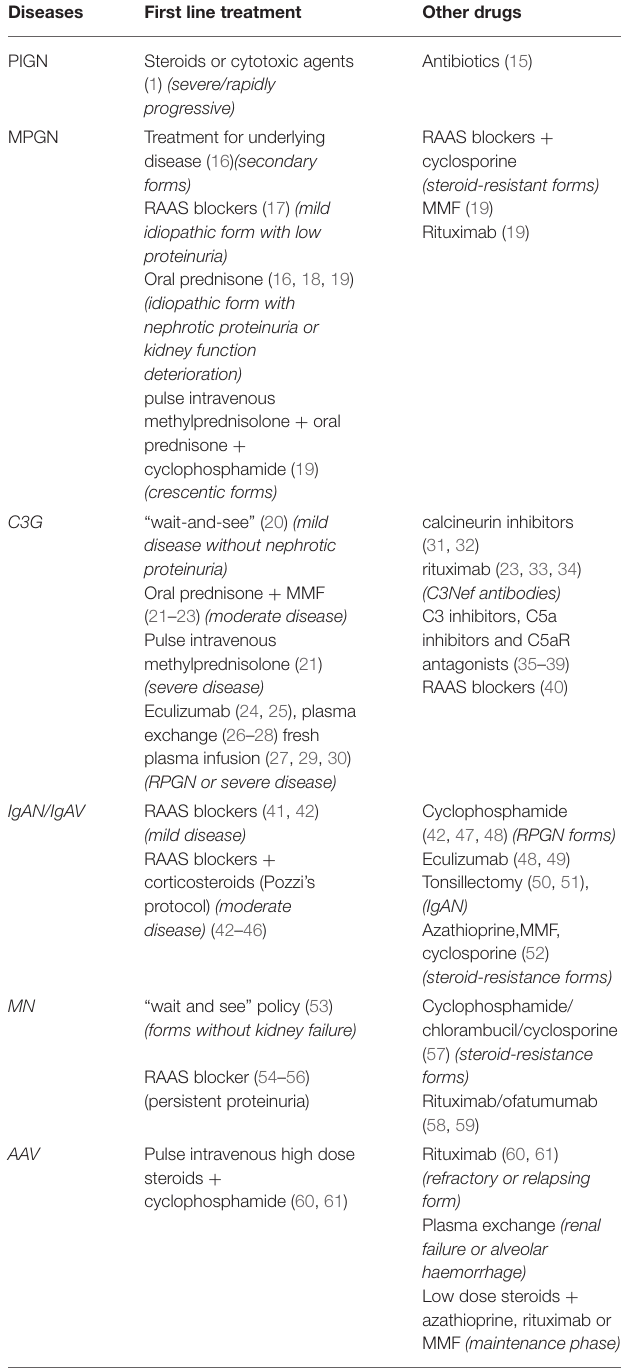
TABLE 3 | Therapeutical options for